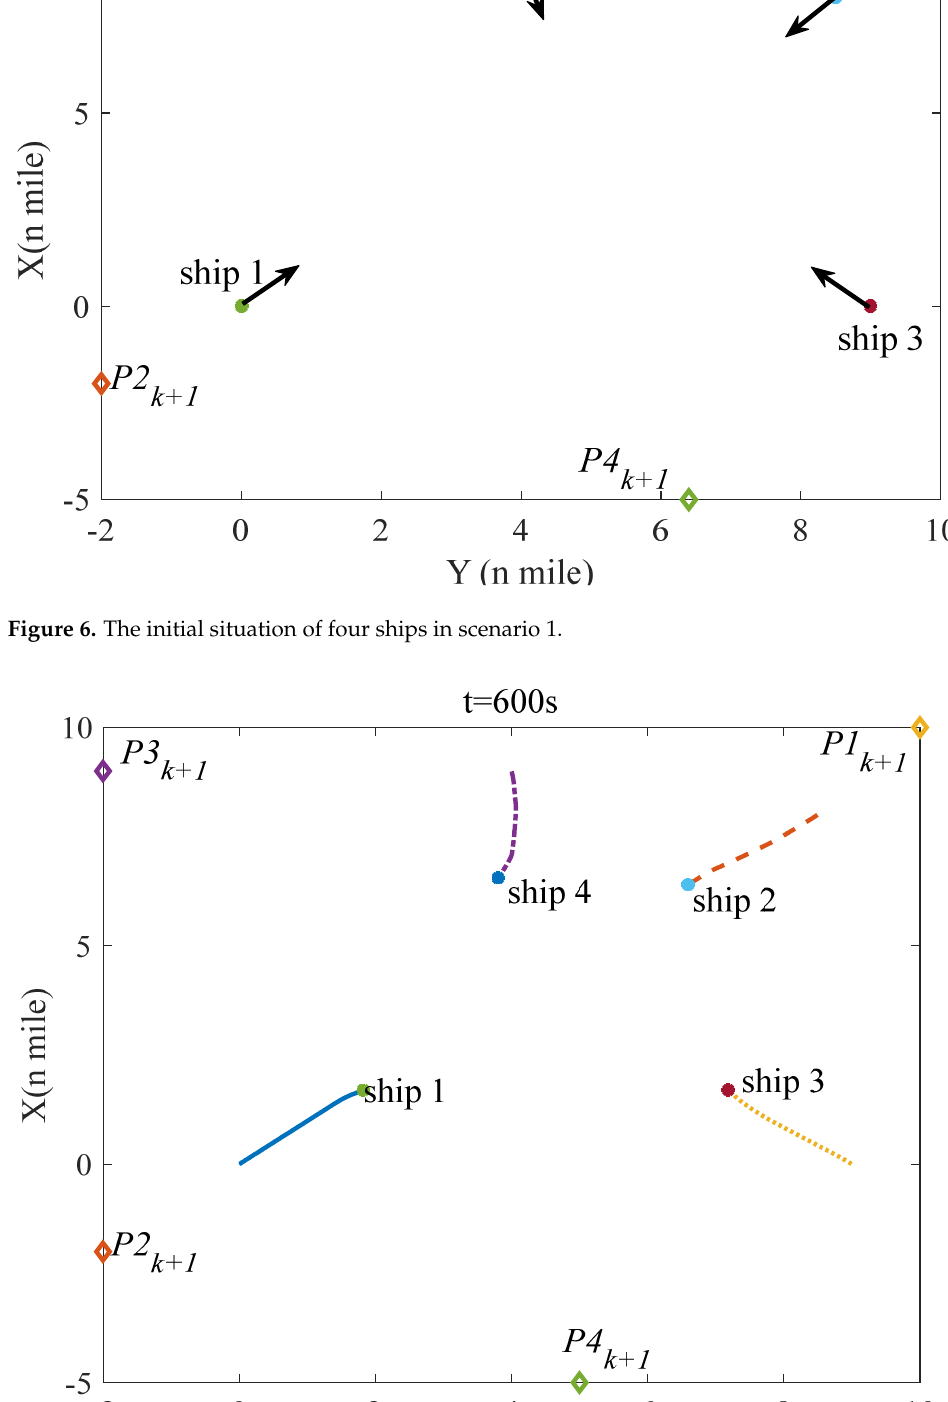
Figure 8. The situation of four ships at t = 1200 s in scenario 1. X ( n m il e )